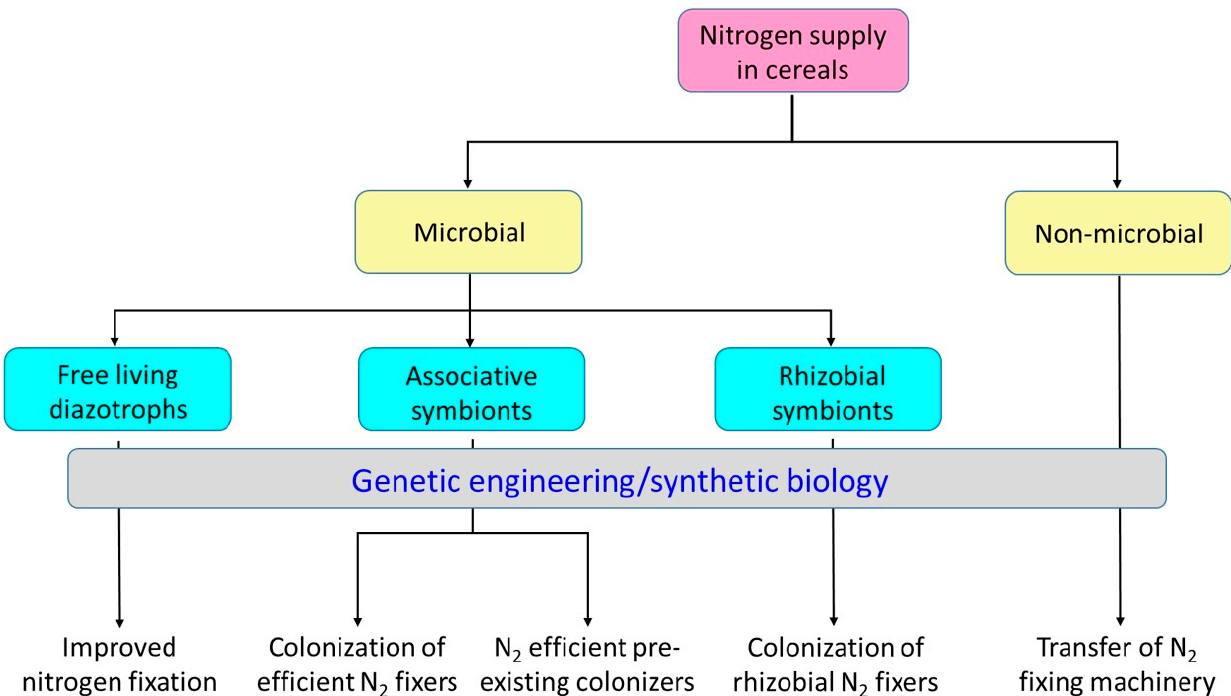
Figure 2. Genetic engineering approaches to improve the availability of biologically fixed nitrogen in cereal crops.